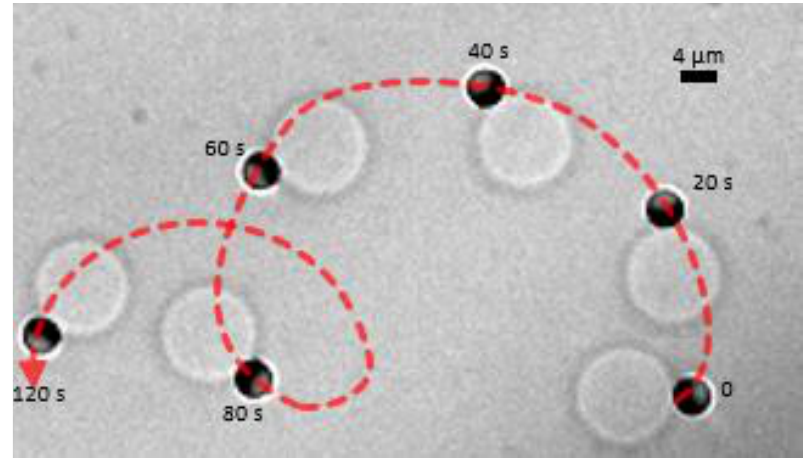
Figure 7. Time-lapse bright field optical microscopy images of the active transport of a ≈ 12 µm giant POPC vesicle by a Pt – SiO 2 Janus microparticle (Pt is the darkest region in the image) self-propelling in a 2% H 2 O 2 solution. The experimental time t (s) is shown close to the microparticle at each snapshot. Dashed red line shows the smoothed particle trajectory.